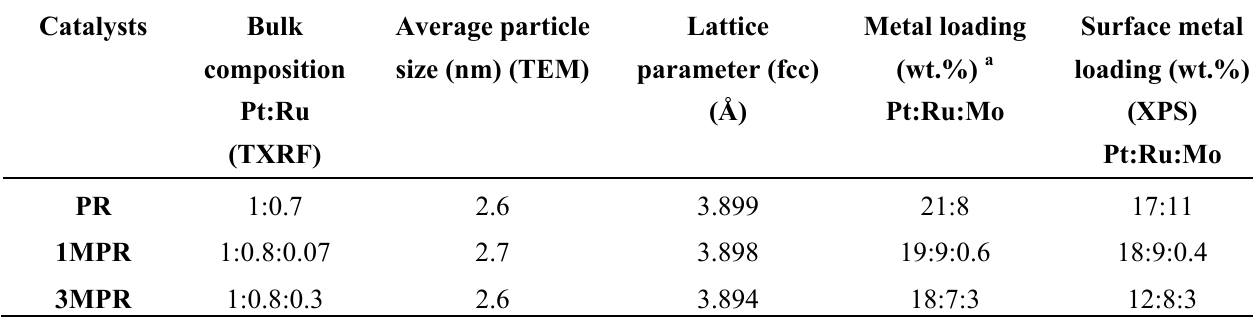
Table 4. Effect of composition. Structural parameters of the samples.